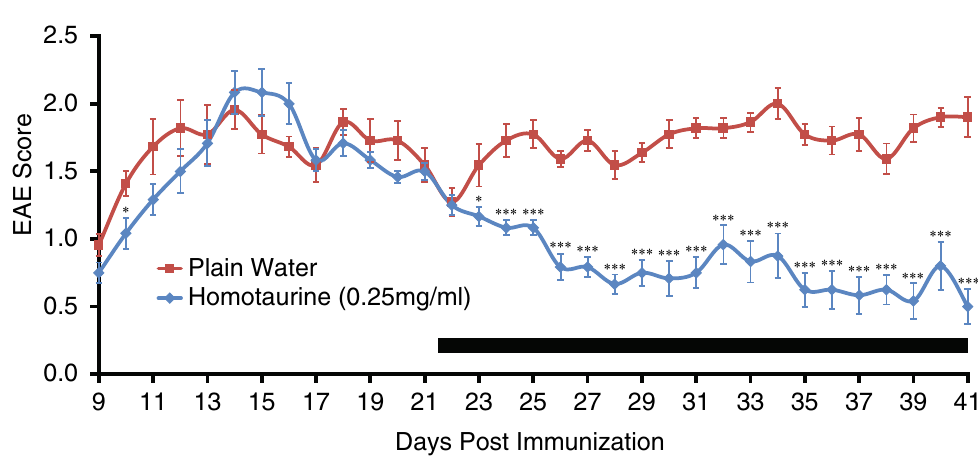
Figure 2. Homotaurine treatment initiated just before the second attack prevents EAE relapse. EAE was induced in SJL mice using PLP 139-151 (as in 26 ). Twenty-two days post-immunization, some mice were given homotaurine (0.25 mg/ml) continuously through their drinking water. The black bar indicates the period of homotaurine treatment. *p < 0.05, ***p < 0.001 vs. plain water control group by Student’s t-test. N = 11–12 mice/ group